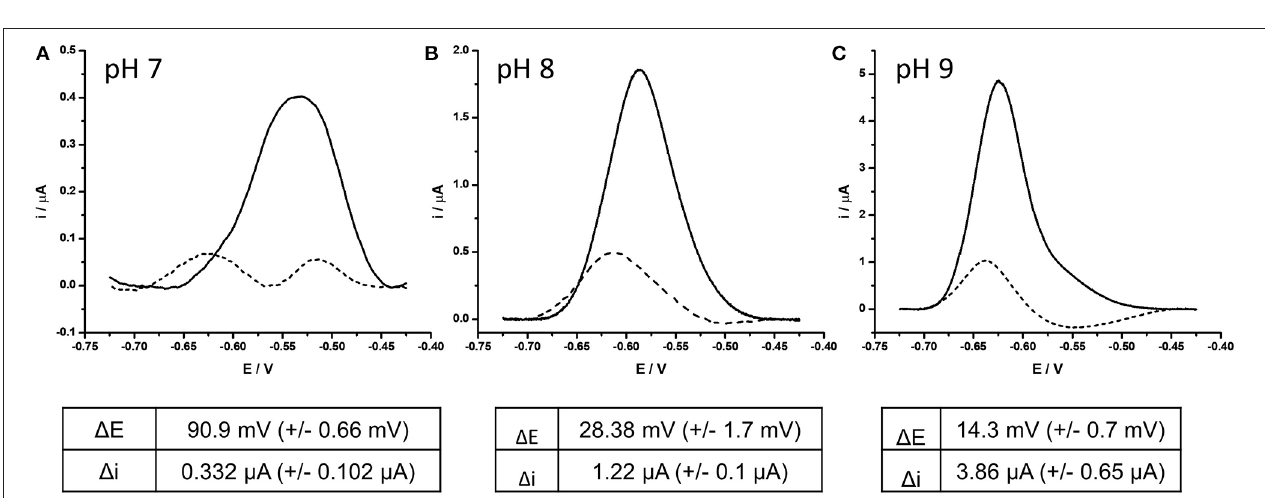
FIGURE 4 | Effect of complementary DNA binding to probe BA-1 at (A) pH 7, (B) pH 8, (C) pH 9. In each case, AQ labeled probe BA-1 was measured as single stranded DNA using DPV (scan − 0.4V to − 0.75V; 50mV s − 1 vs. SCE) under oxygenated conditions in measurement buffer 10mM Tris pH 8, containing 0.5M NaCl (solid line) prior to hybridization to fully complementary DNA (dashed line). The response of the same electrode under all conditions is shown and is representative of the three electrodes tested under the same conditions.